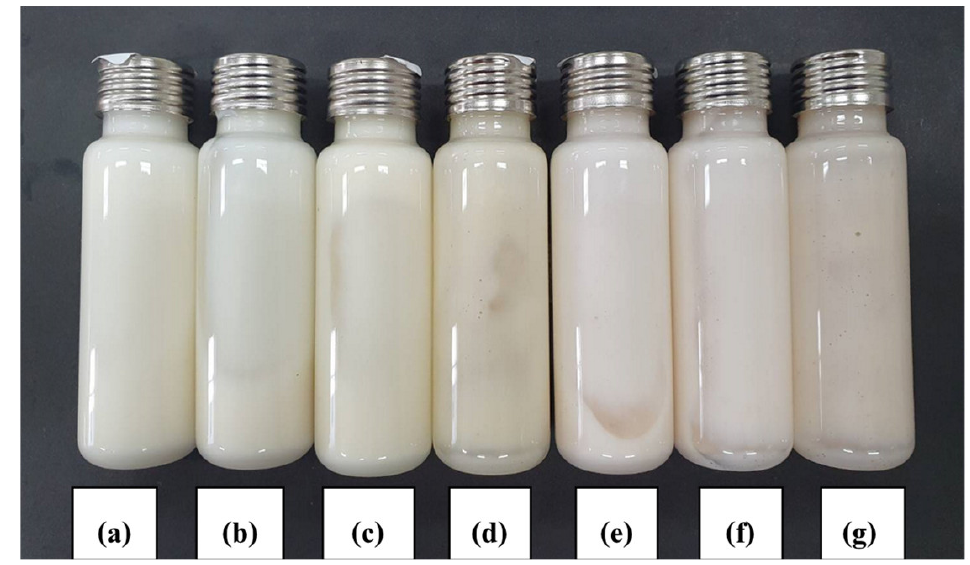
Figure 6. Deodorant cream with 2.5% H-CMCH by heating/cooling cycle; ( a ) cycle 0, ( b ) cycle 1, ( c )